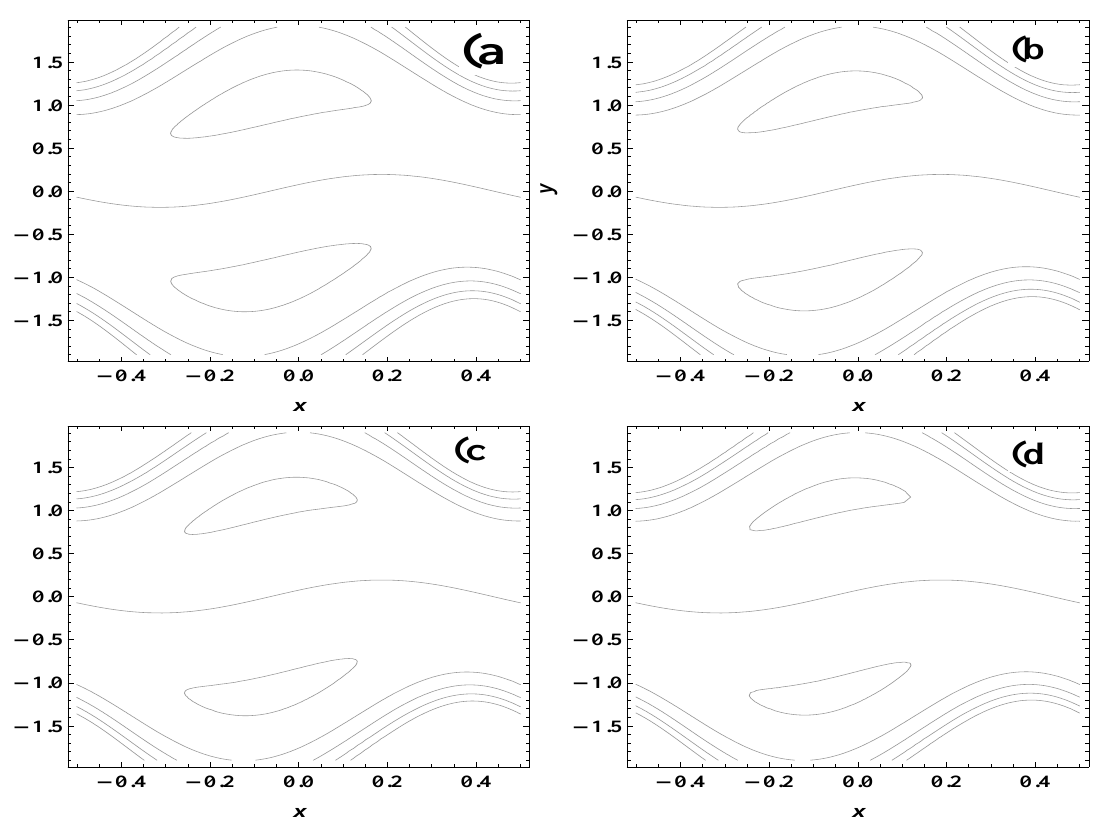
Figure 7. Effect on trapping by M with Q = 1.48, ϕ = π /4, λ 1 = 1(a); M =0,(b); M =1,(c); M =1.3,(d); M